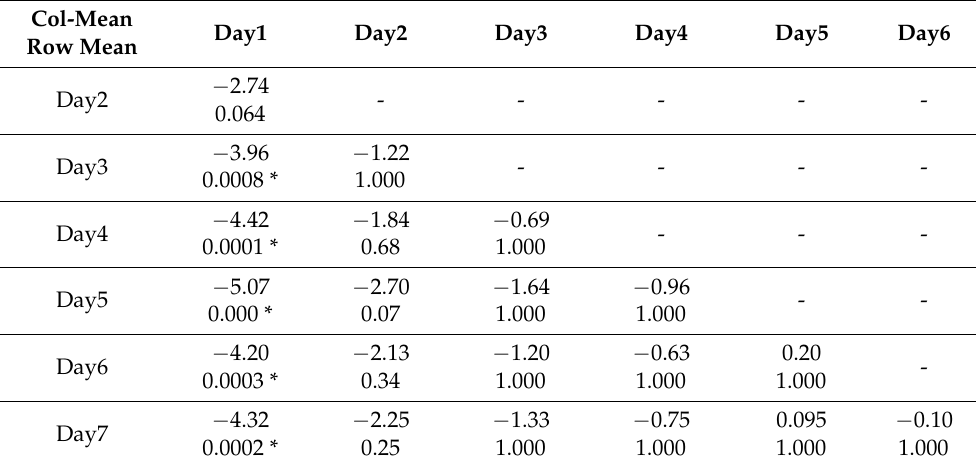
Table 4. Dunn’s test pairwise comparison between the accuracy of classification using different amounts of data (day-wise). (Significant difference exist where “*” is